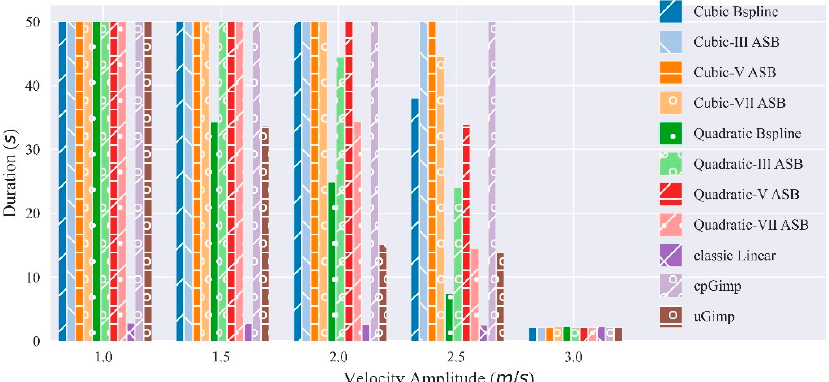
Figure 9. Maximum durations for MPM variations to maintain 1D continuum bar vibration within 5% error.